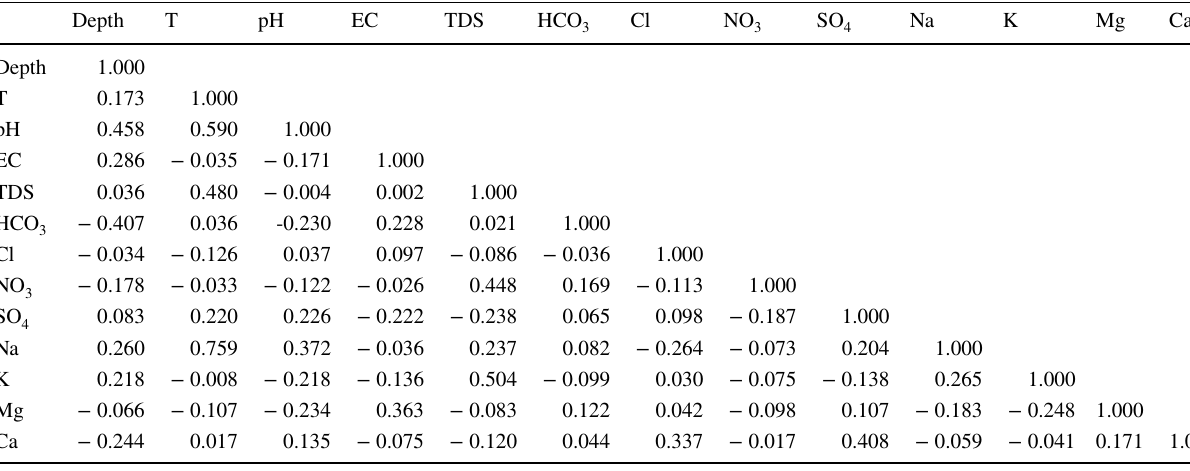
Fig. 5 Distribution of ESP: a Wilcox diagram; b Riverside diagram Table 2 Pearson correlation of the measured concentrations